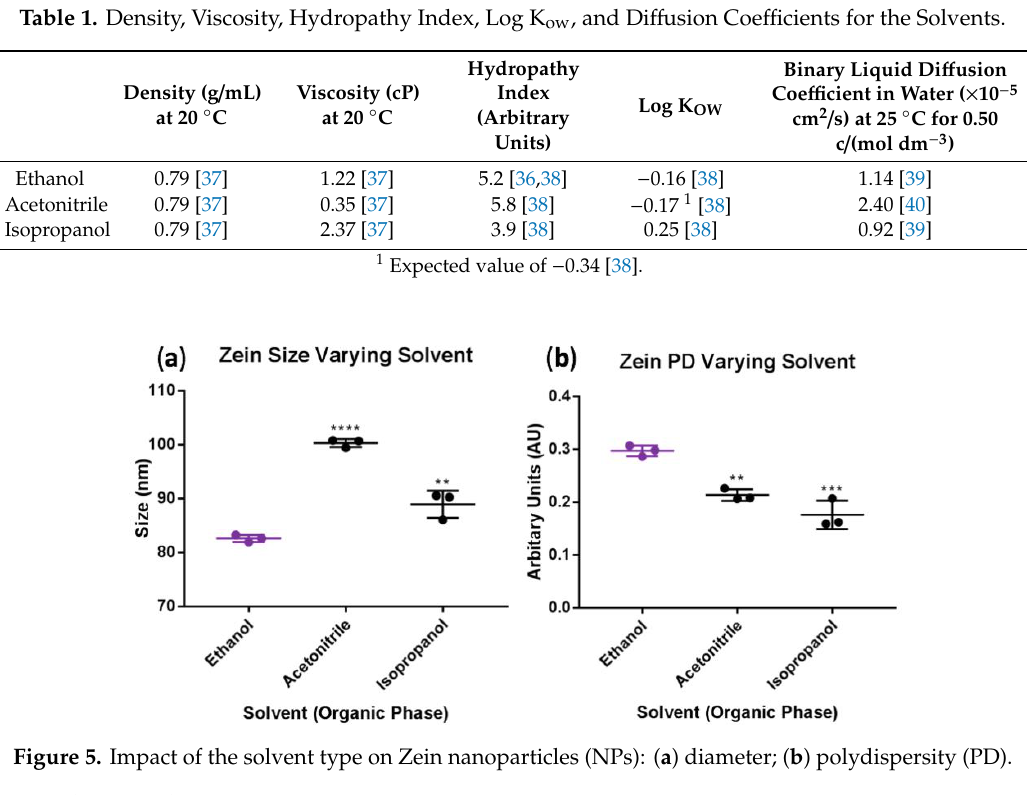
Table 1. Density, Viscosity, Hydropathy Index, Log K ow , and Diffusion Coefficients for the Solvents. Density